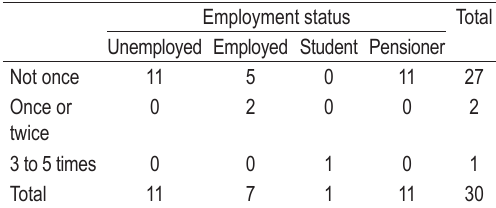
Table 4. Frequency of forgetting to take medicine over the past two